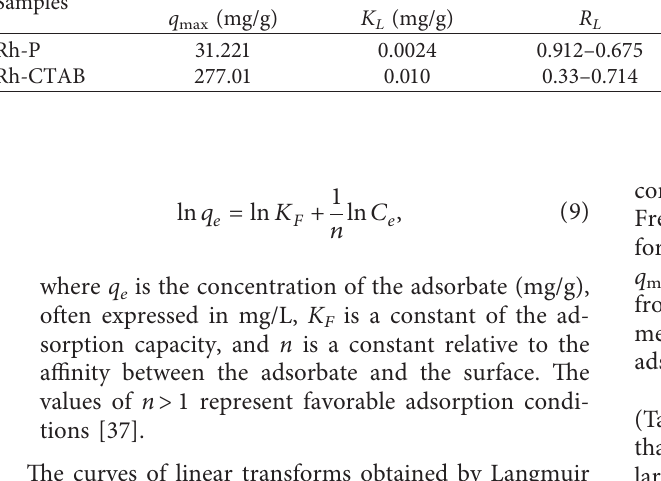
values of n > 1 represent favorable adsorption condi- tions [37].